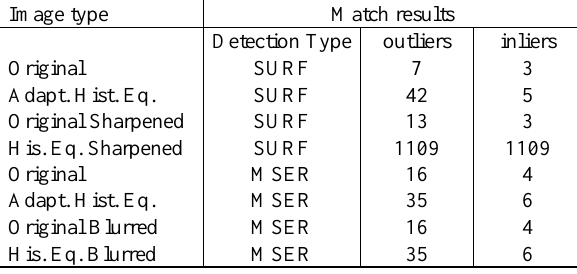
Table 5. Results of the experiment 4